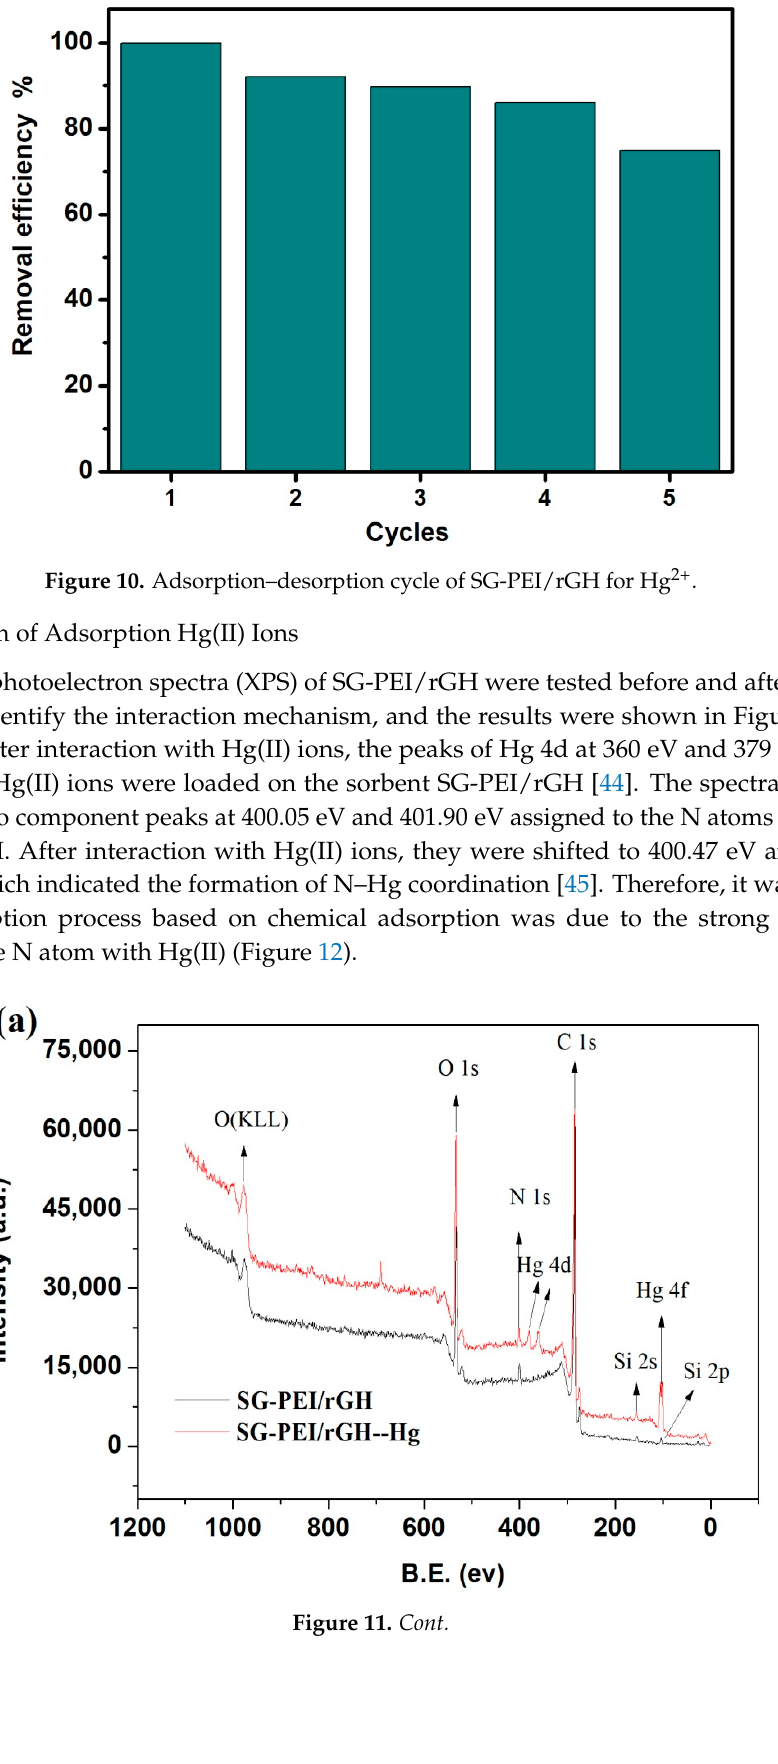
Figure 11. ( a ) XPS wide scan and ( b,c ) N1s spectrum of SG-PEI/rGH and SG-PEI/rGH-Hg. Figure 12. Mechanism for adsorption of Hg(II) on SG-PEI/rGH. 4. Conclusions In summary, 3D, reduced graphene oxide hydrogel (rGH)-modified SG-PEI was prepared and employed in the adsorption Hg(II) ions. Compared with SG-PEI, it showed an improvement in